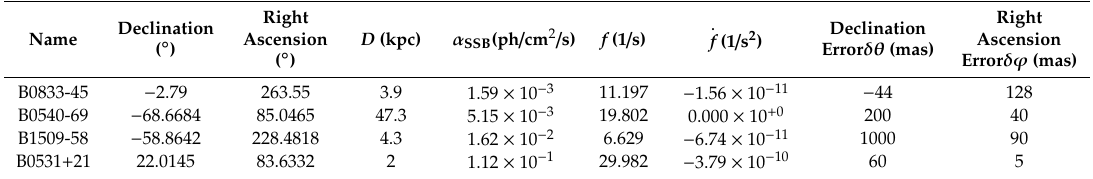
Table 1. Parameters of navigation pulsars [20,29].